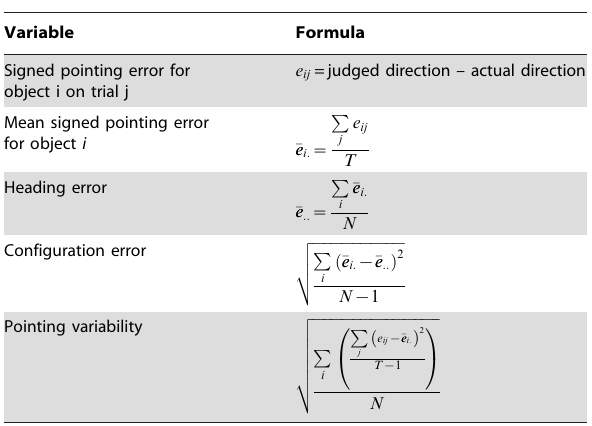
Variable Formula